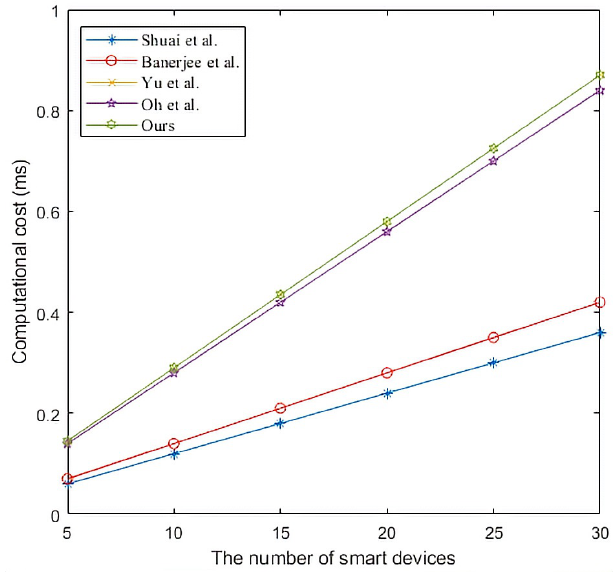
Figure 9. The computational cost of smart devices. Shuai et al. [37], Banerjee et al. [40], Yu et al. [18], and Oh et al. [42].